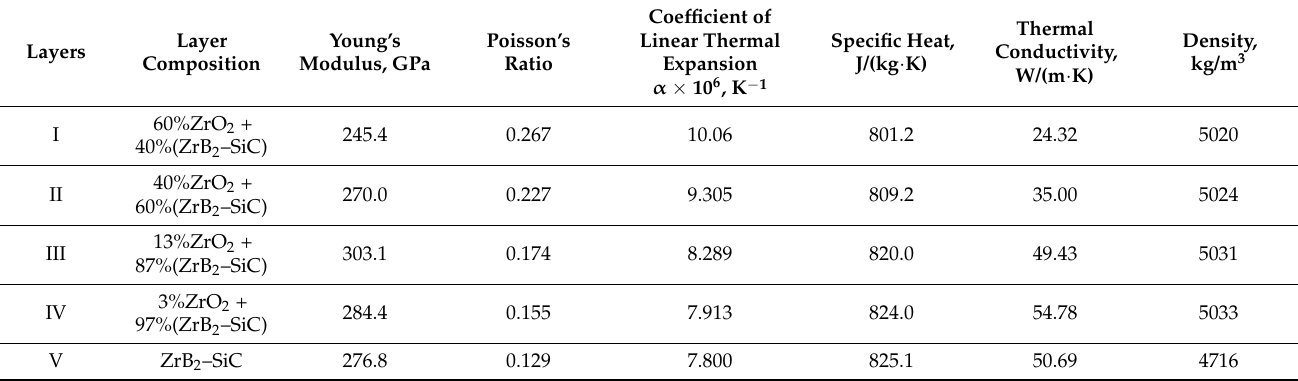
Table 1. Physical and mechanical properties of the composite layers.